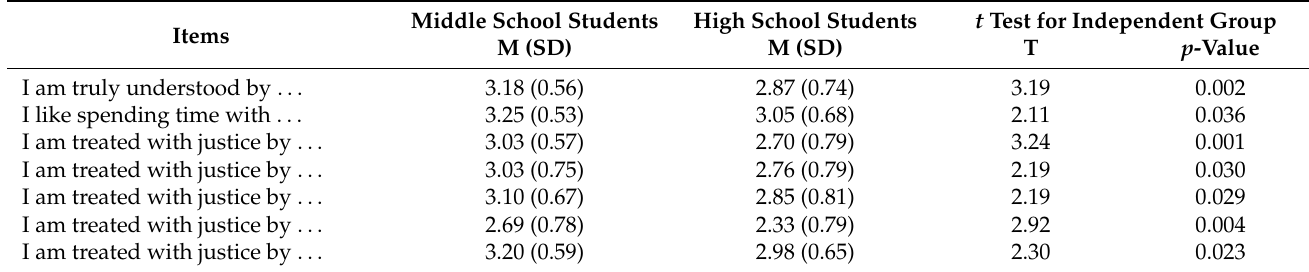
Table 5. The Independent Samples t Test: significant items of Peer Relationship Scale.